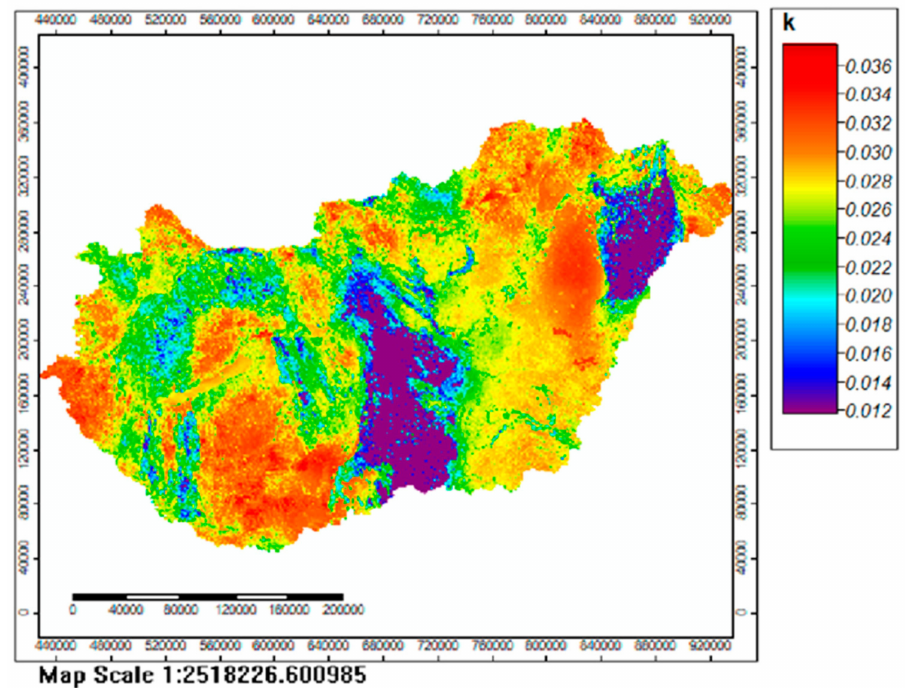
Figure 3. Universal Soil Loss Equation (USLE) K factor in